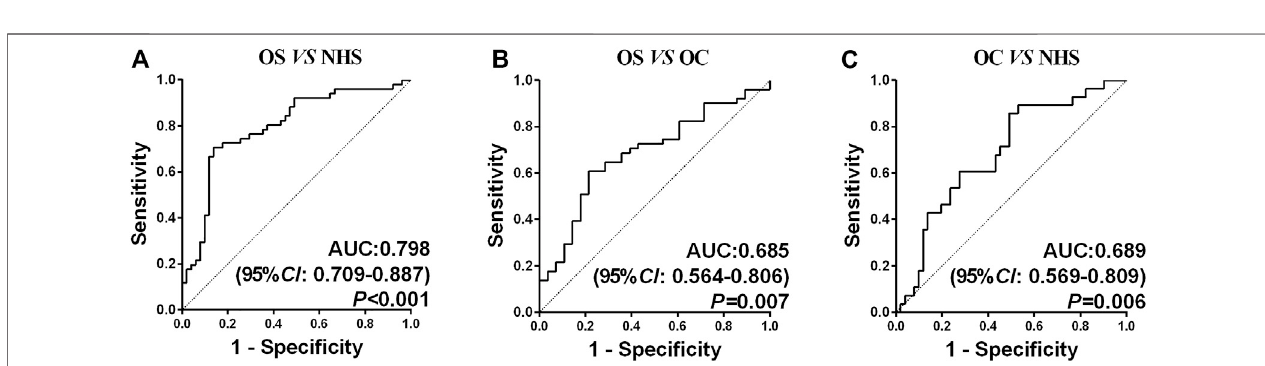
FIGURE 3 | ROC curve analysis of the prediction model with the TAA panel of OS detection. (A) Prediction model with three TAAs for OS detection in healthy controls. (B) Prediction model with three TAAs for OS detection in OC. (C) Prediction model with three TAAs for OC detection in healthy controls.